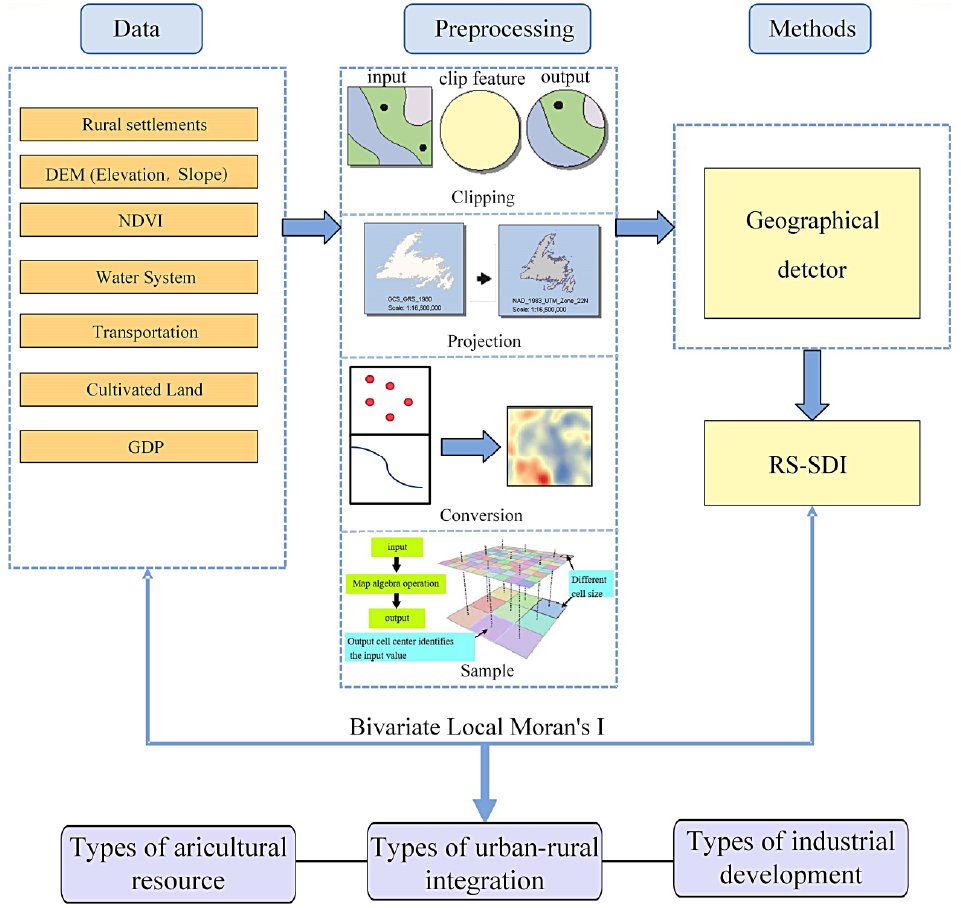
Figure 3. Methodological flow chart. (Note: The images of the clipping and projection parts of the diagram are derived from the illustrations in the Arcgis program).